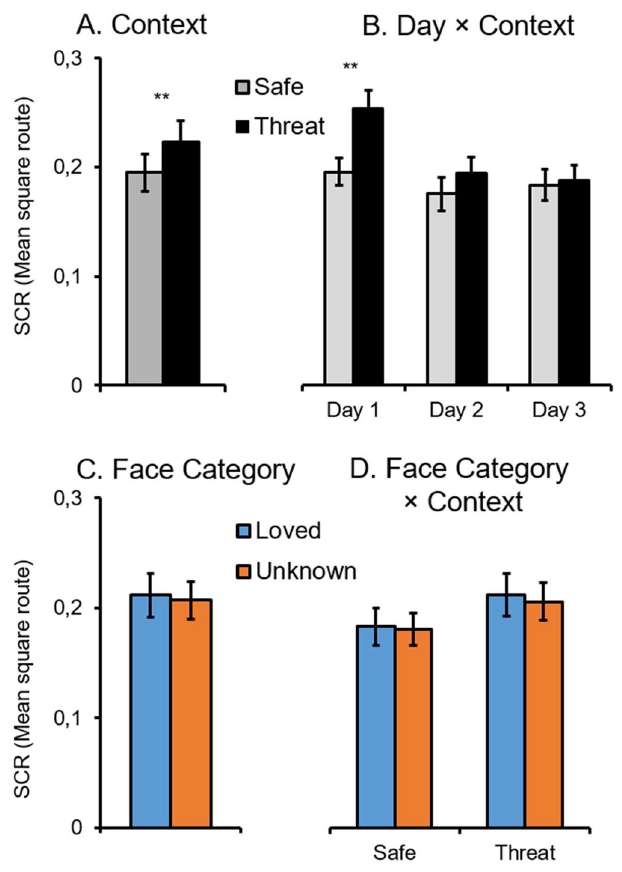
Figure 4. Mean skin conductance responses as a function of ( A ) instructed context condition, ( B ) context across test days, ( C ) face category, and ( D ) interaction of face category by context condition (M and SEM, ** p <